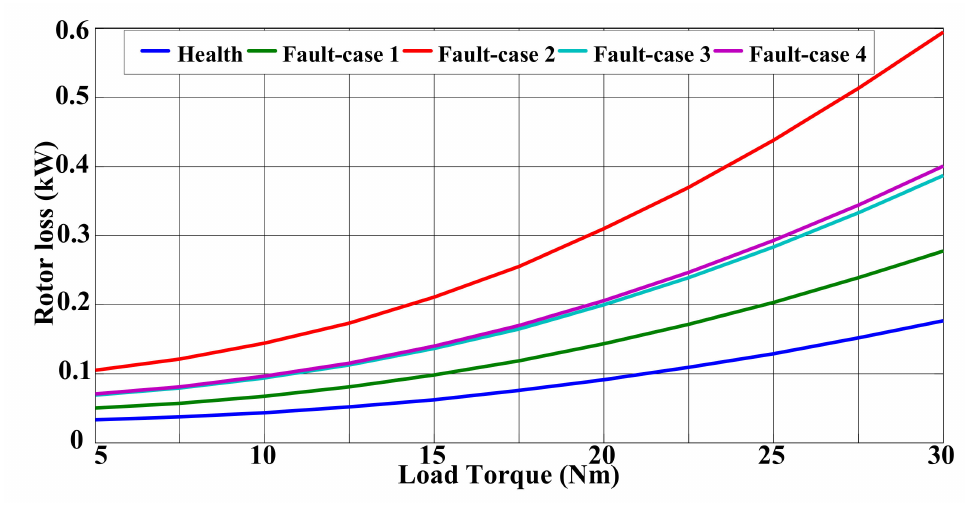
Figure 9. Calculated rotor Joule loss varying with torque.